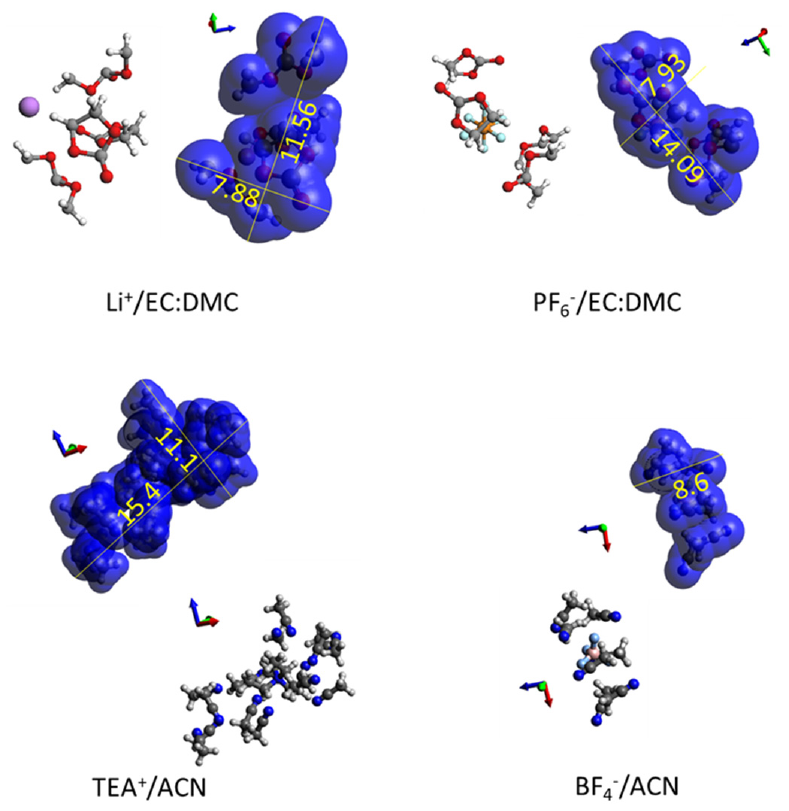
Figure 2. Solvated ions of electrolytes LiPF 6 /EC:DMC and TEABF 4 /ACN in ball-and-stick represen- tation and also wrapped with the van der Waals surface (or Connolly surface). The next issue to address is about slit pores smaller than the minimum size of each solvated ion, which happens to be 0.79 nm for both cation and anion in LiPF 6 in EC:DMC, as can be seen in Figure 2, and 1.11 nm for TEA + /ACN and 0.86 nm for BF 4 − /ACN as can be seen in Table SI-1. In this case, the Blends Module in Materials Studio was utilized to determine the adsorption energy of the desolvated ions TEA + and BF 4 − with a graphite sheet (for the simulations of the GCD cycle of a-MWGO EDLC) and the adsorption energy of Li + and PF 6 − ions with the xGNP-750 type of graphitic sheet. The Blends Module uses the Monte Carlo method for sampling of configurations [58] where simulations in the present study for the calculation of adsorption energy employed 107 samples and a reference temperature of 298 K. A graphite sheet of 128 carbon atoms was built and subjected to geometrical optimization. Figure 3 displays the assemblies of Graph128 with the cations and anions for each of the electrolytes: (a) LiPF 6 and (b) TEABF 4 . In general, ion adsorption is observed, with the cations exhibiting higher adsorption energy given the relative electronegativity of graphene; in particular, Li + demonstrates a higher adsorption energy than TEA + . The distance between Li + and Graph128 is also the smallest, compared to the other ions which is due to the small size of the lithium ion as well as the corresponding high adsorption